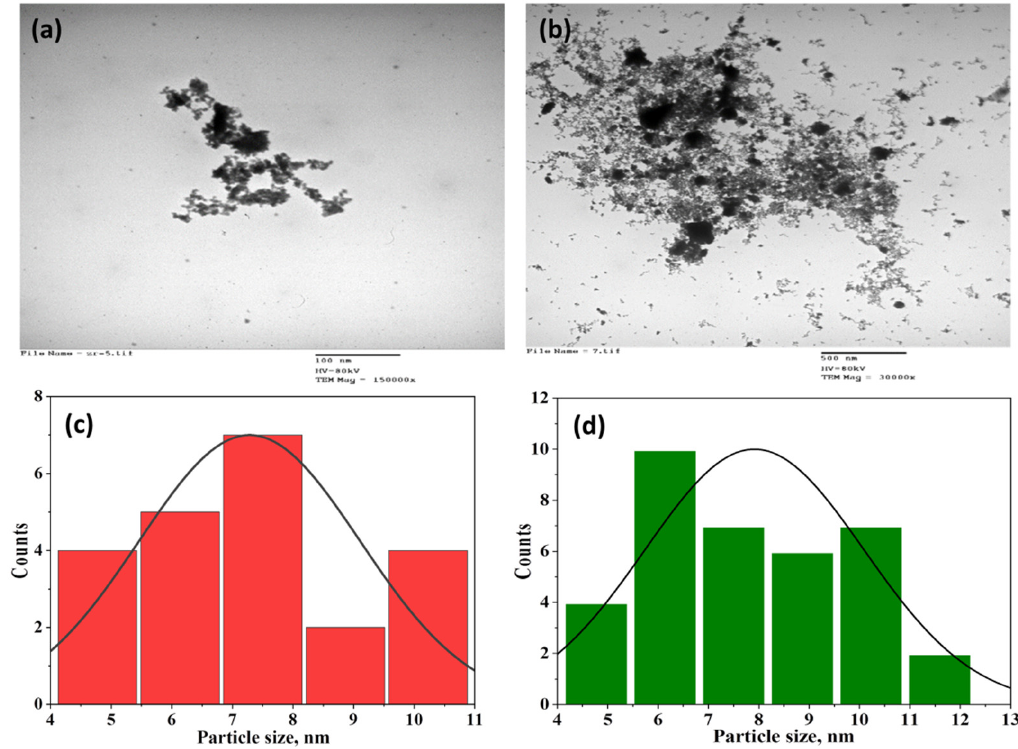
Figure 2. TEM images of ( a ) ZrO 2 NPs570 (scale bar: 100 nm), ( b ) ZrO 2 NPs700 (scale bar: 500 nm), and their respective particle-size distributions ( c , d ).